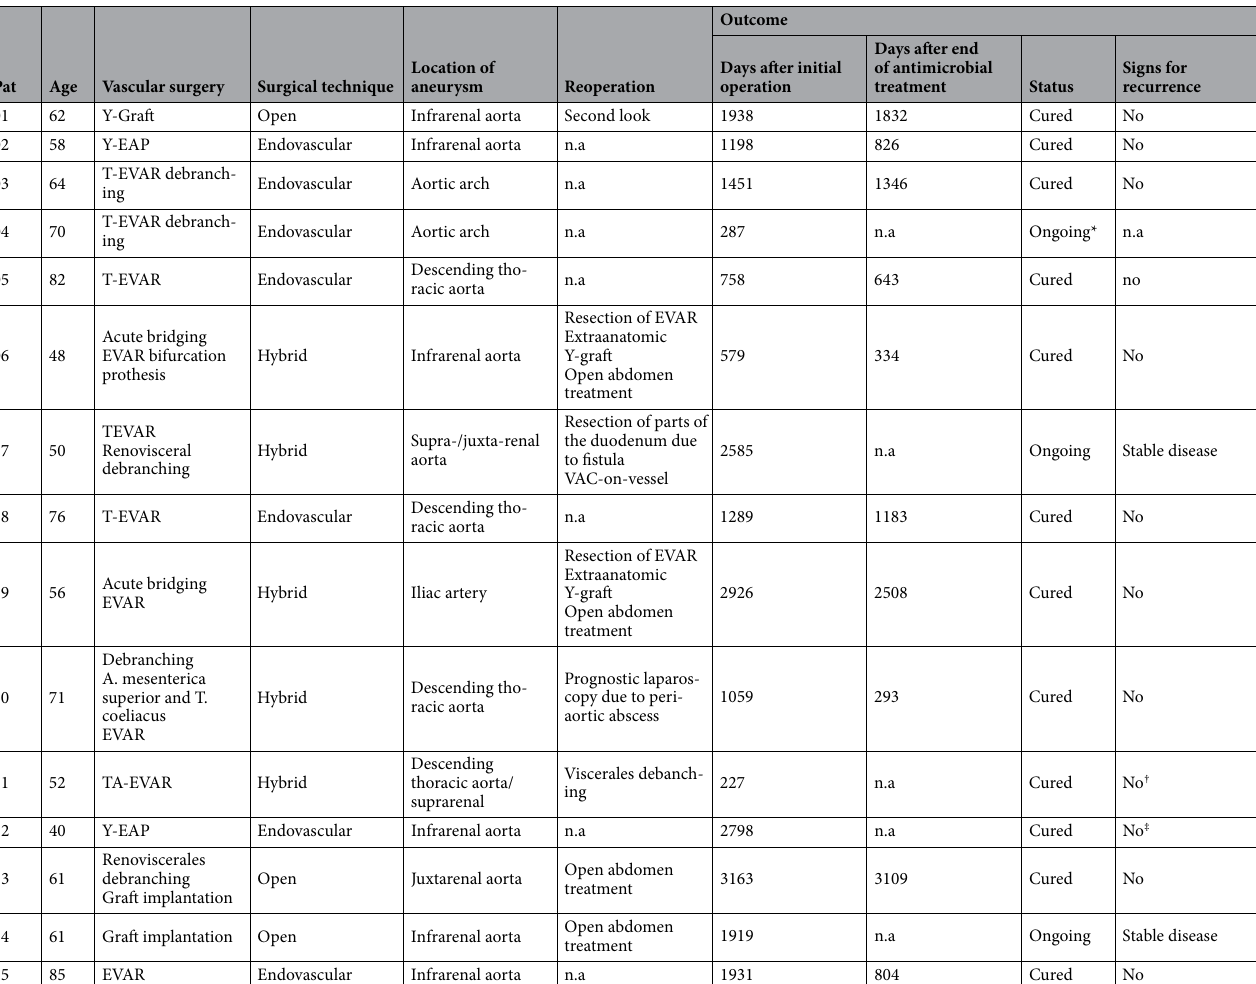
Table 1. Patient demographics, data on interventional procedures, and patient outcome data of the final study population in patients with proven infective native aortic aneurysms. Pat: Patient number; na, not applicable. *Patient died due to gastrointestinal bleeding, no relation to thoracic INAA. † Patient developed 1.5 years later an infected pancreatic cyst. ‡ The active intravenous drug user died 8 years later due to aortic valve